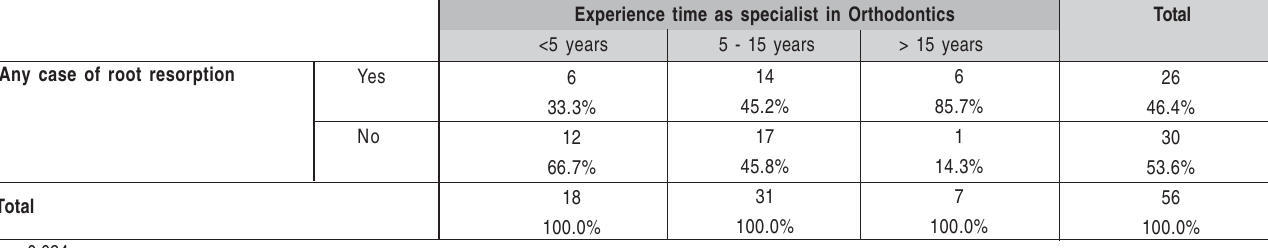
Table 3. Frequency distribution of Orthodontists that had already had a case of root resorption caused by the orthodontic treatment, stratified by the experience time as a specialist.